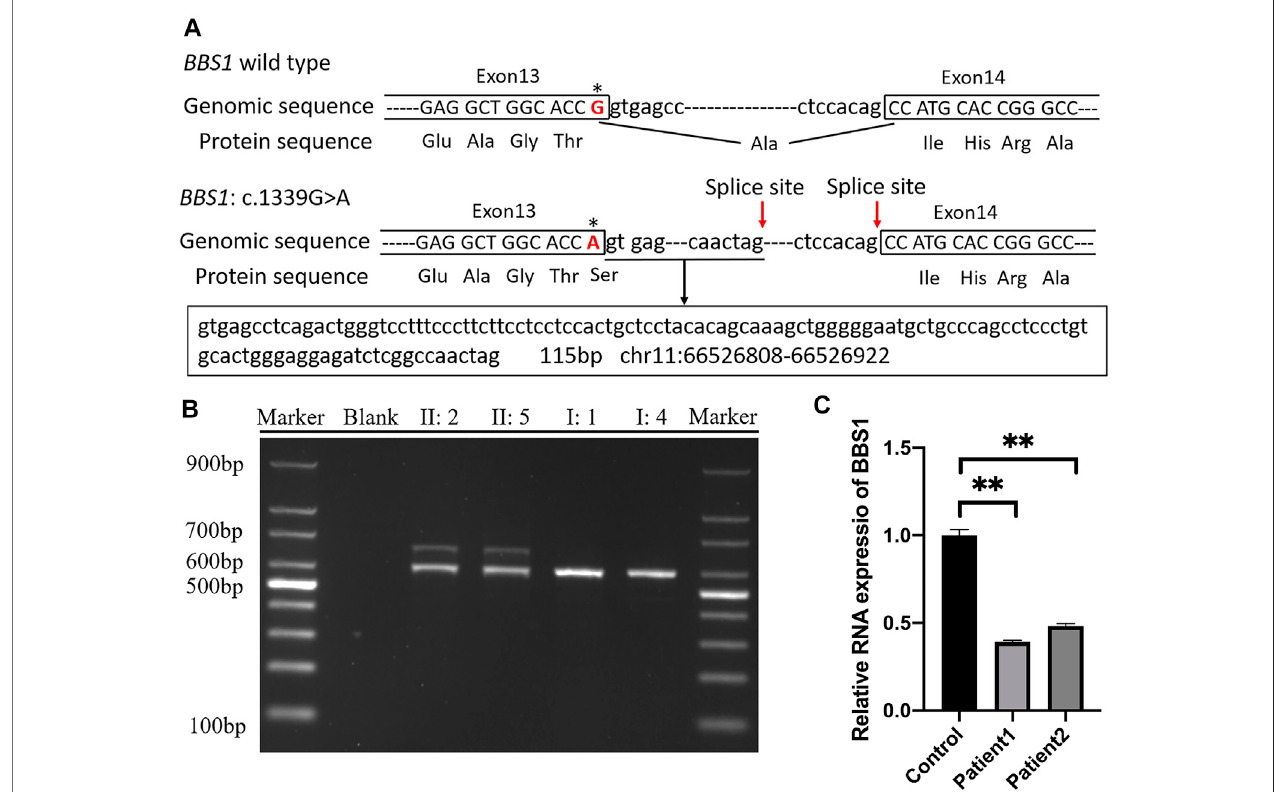
FIGURE 3 | (A) Schematic representation of exon 13, intron 13, and exon 14 organization in BBS1 ; (B) RT-PCR analysis of exons 13 – 15 of the BBS1 cDNA from peripheralbloodmononuclearcells(PMBCs).AgarosegelelectrophoresisofRT-PCRproductsgeneratedfromheterozygousII:2,II:5,I:1,andI:4. (C) Real-timeRT-PCR of carrier couple and the control lymphoblast cells, revealing half of the BBS1 transcript in the carriers ’ PBMCs. Error bars indicate SE of the means; p -value < 0.05 (unpaired t